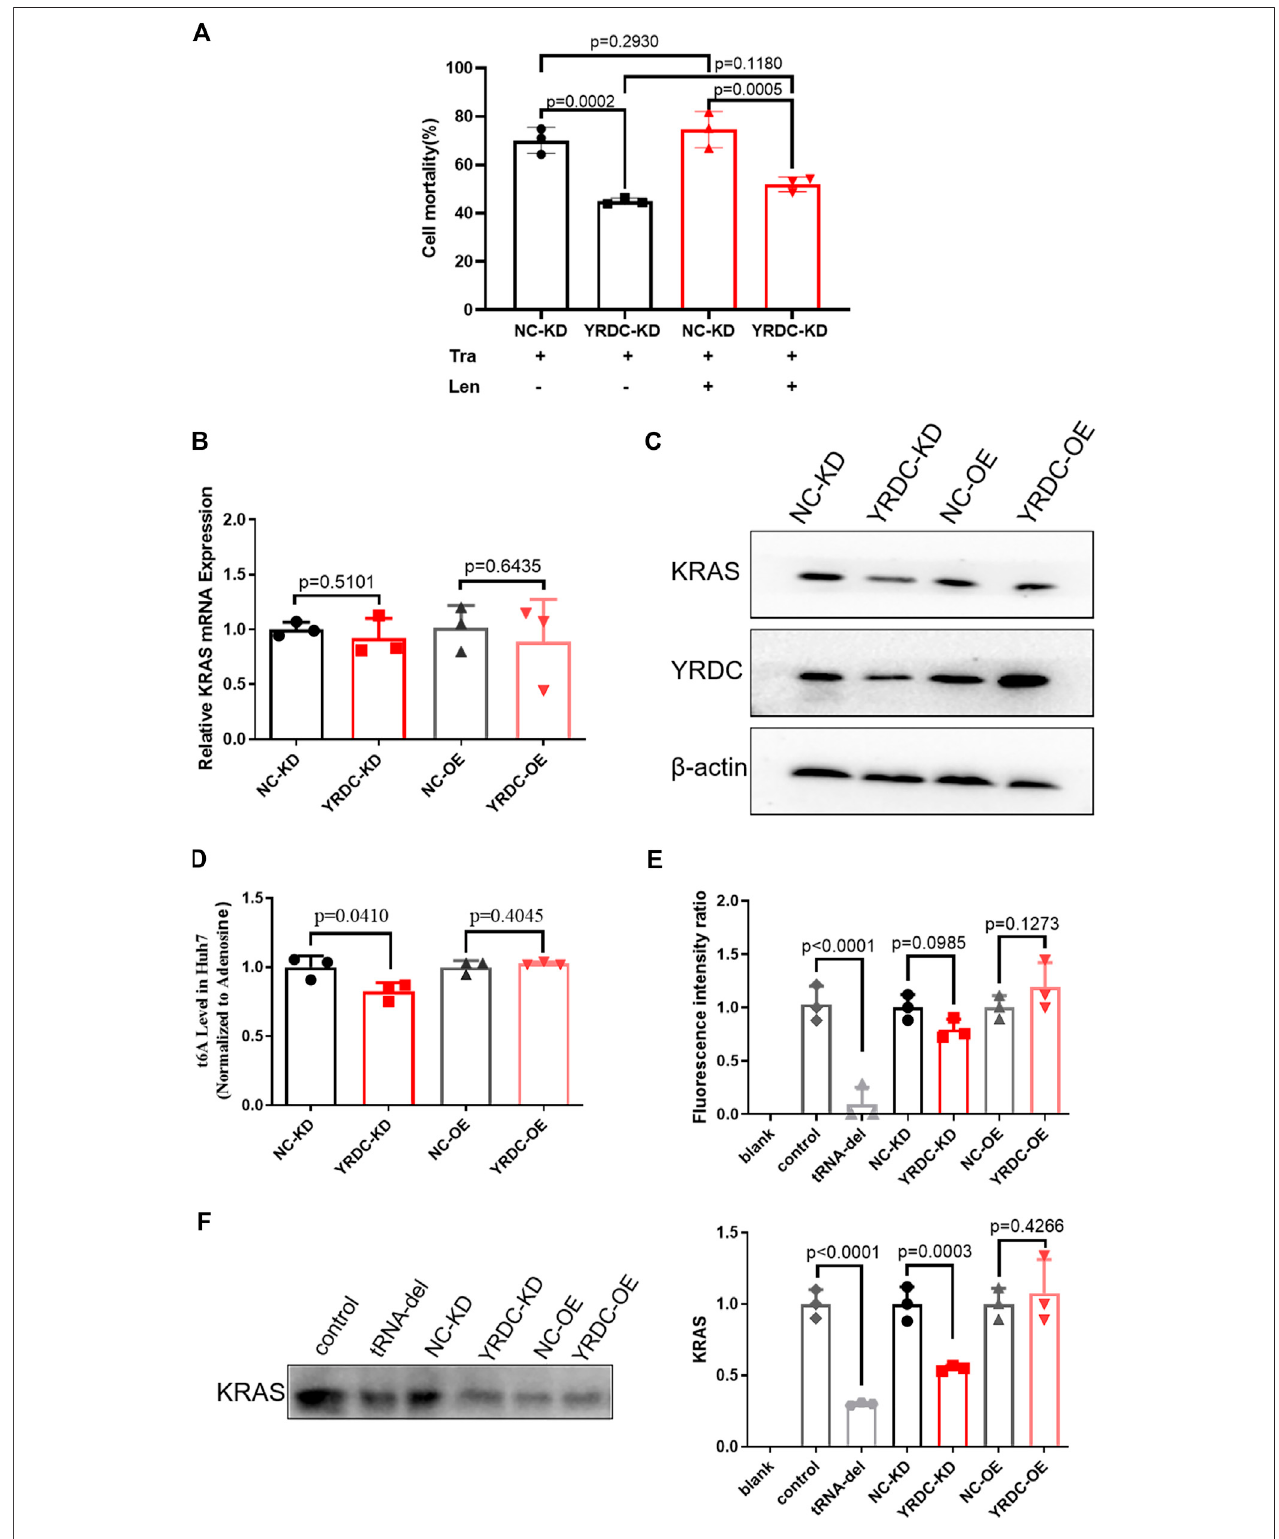
FIGURE6| Theanti-cancereffectofYRDCmightaffecttheKRASproteinlevels,butnotmRNAlevels. (A) TheknockdownofYRDCattenuatescellularsensitivityto trametinib. After inhibiting the activity of the MAPK pathway, the expression of YRDC no longer affected the sensitivity of lenvatinib. (B) The mRNA expression levels of